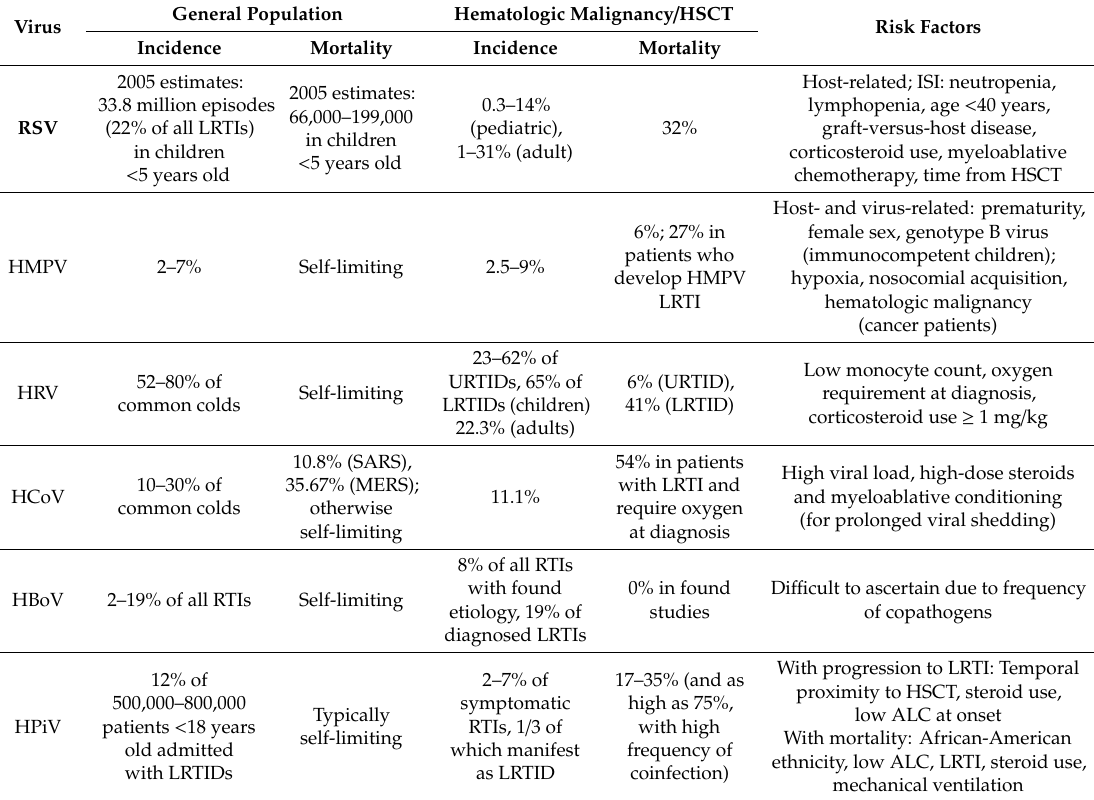
Table 4. Summary of epidemiological